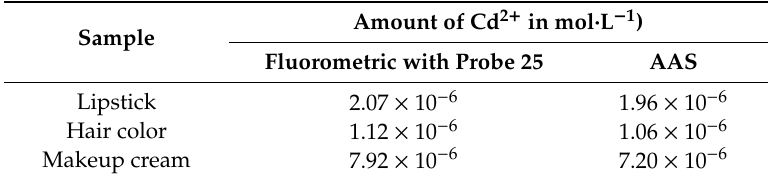
Table 2. The calculated concentration of Cd 2 + ions in cosmetics and personal care samples by fluorometric and atomic absorption spectroscopy (AAS) [179].